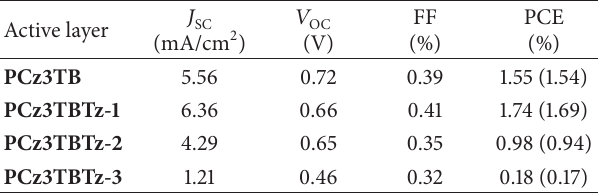
BM OPV cells a,b 71